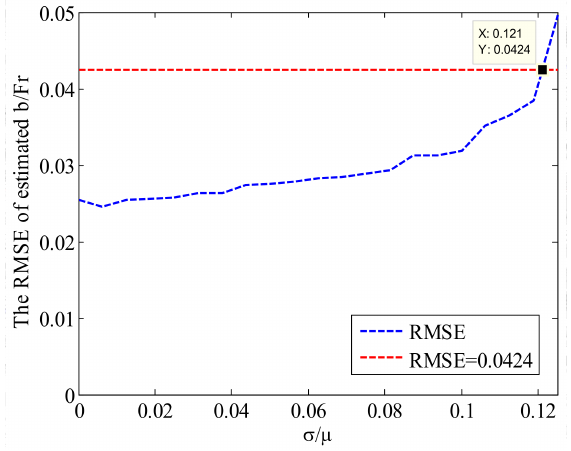
Figure 6. The RMSE of the estimated b / F r as a function of σ / µ